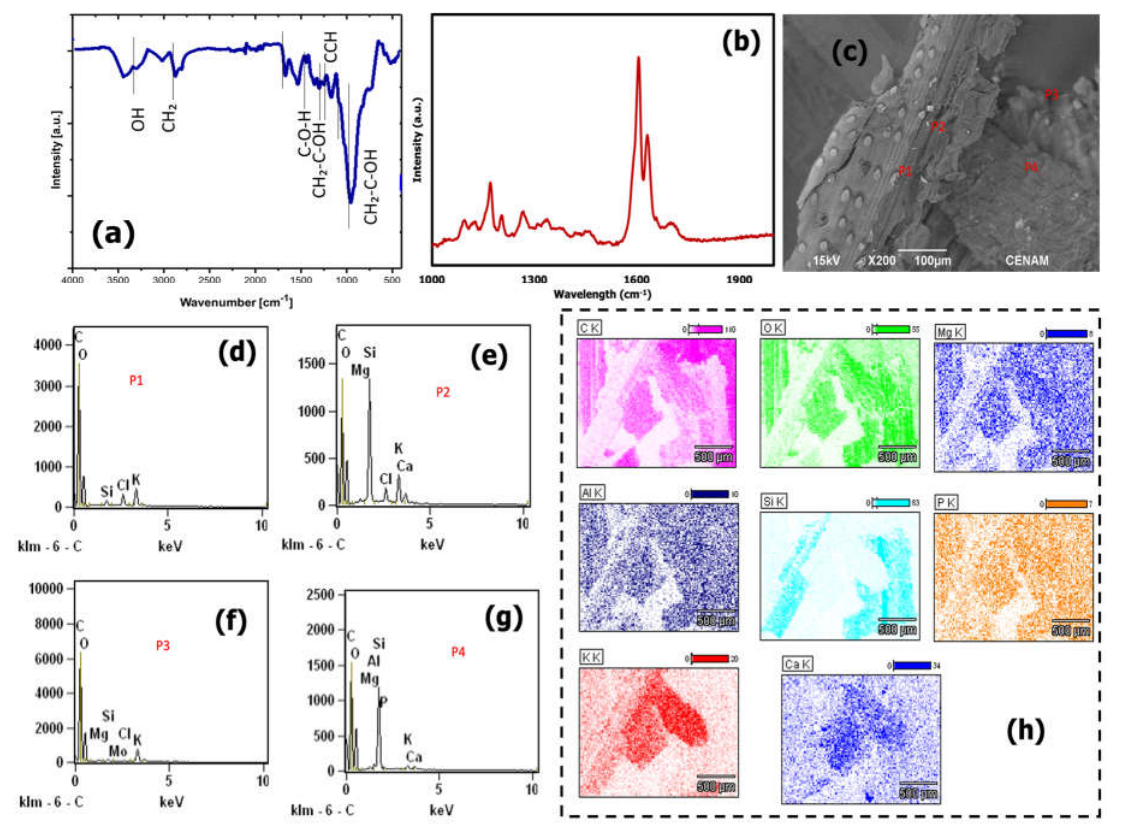
Figure 2. ( a ) FTIR ( b ) Rama spectroscopy ( c ) SEM, semi-quantitative chemical analysis: ( d ) point 1 ( e ) point 2 ( f ) point 3 ( g ) point 4 ( h ) chemical mapping. Table 1. Mass percentage of the elements present in the biomass of corn stubble